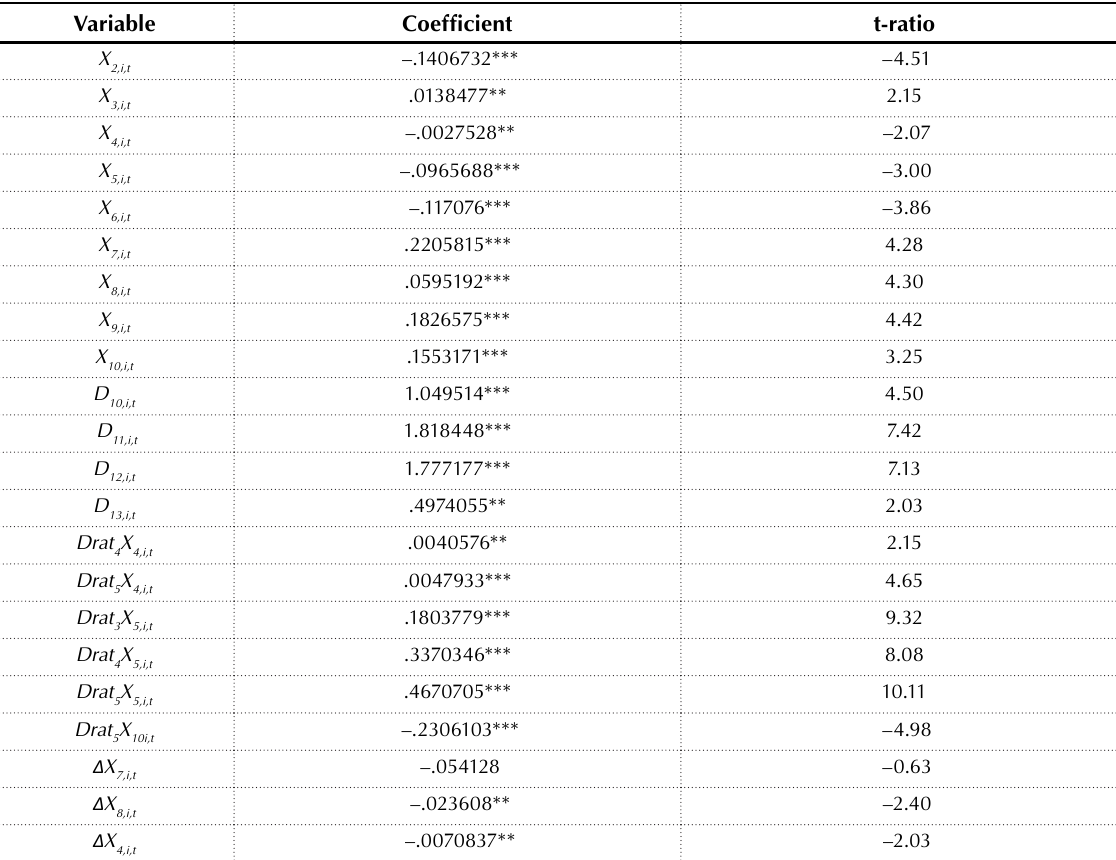
Table 1. Estimation results: panel ordered